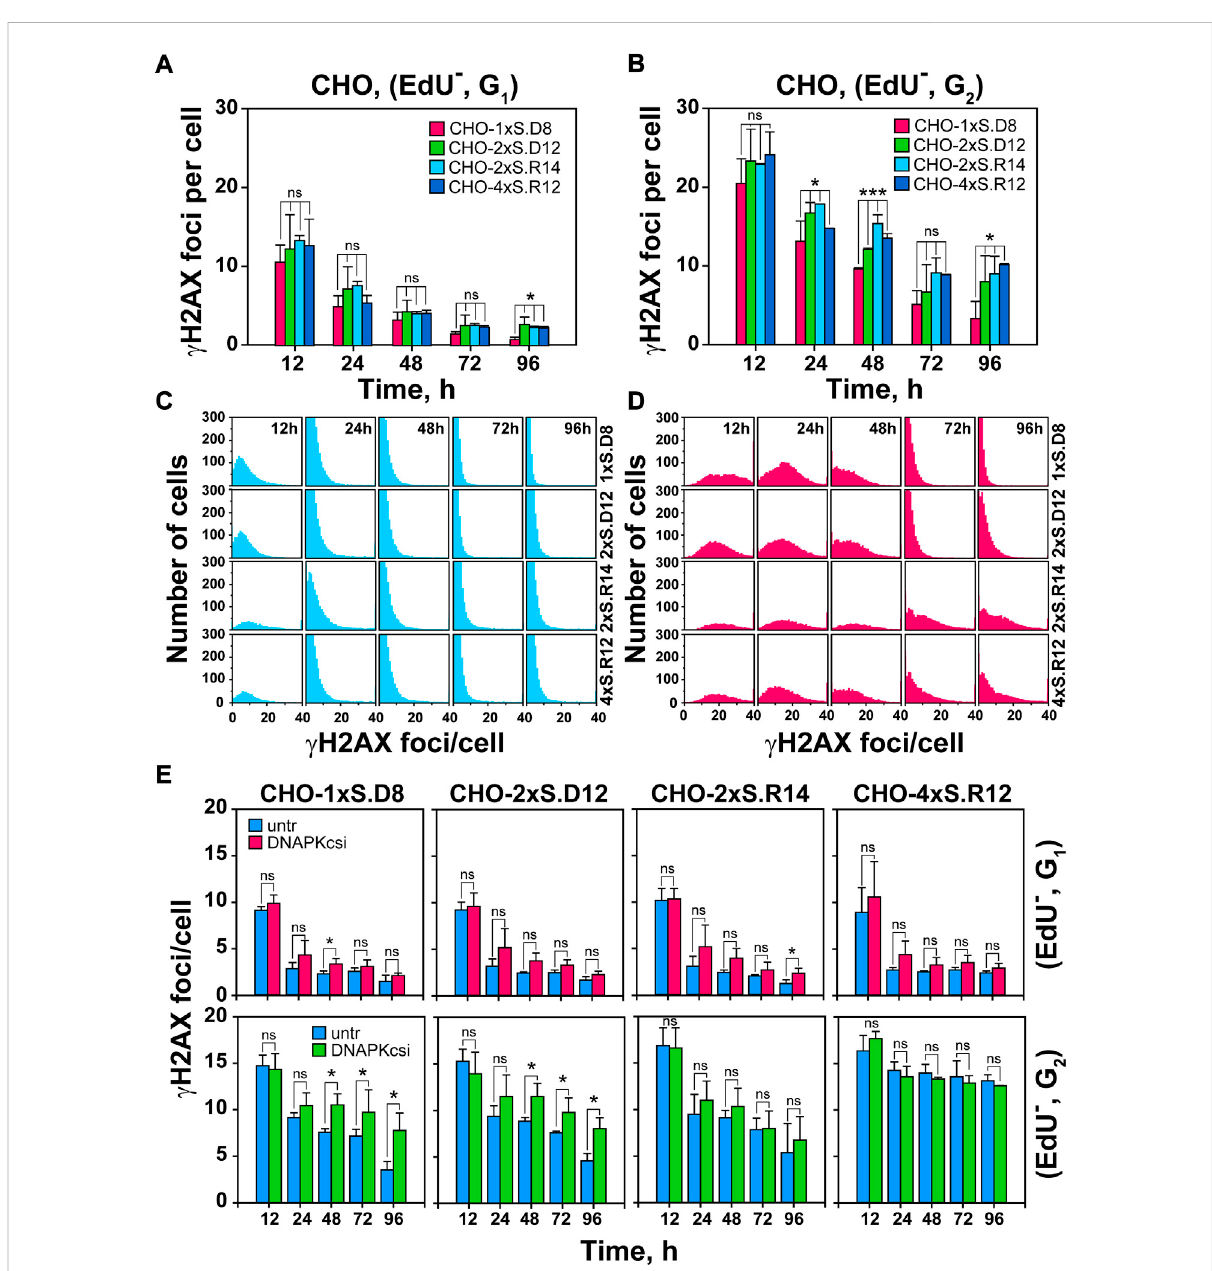
FIGURE 2 Increased DSB-complexity correlates with attenuated decay of γ H2AX foci in G 2 -phase cells; impact of DNA-PKcs-inhibition. (A) Quantitative analysis (QA)of γ H2AXfociformation anddecay inG 1 -phase cells,selectedaccordingto thegates de fi ned inSupplementaryFigure S1A.Fociscored inI-SceItransfectedcellsissubtractedfromthebackgroundfociscoredinmocktransfectedcells. (B) AsinFigure2A,butforEdU − ,G 2 -phasecells (C) Histogram plots of γ H2AX foci in EdU − , G 1 -phase cells. (D) As in Figure 2C, but for G 2 -phase cells. (E) Upper Panels: QA of formation and decay of γ H2AX foci in I-SceI transfected, G 1 -phase cells, after DNA-PKcs inhibition. DNA-PKcsi was administered immediately after transfection and was kept for 24 h. Lower Panels: As in the upper panels but for EdU − , G 2 -phase cells. Data represent means and standard deviations (±SD) from three independent experiments. (ns, no signi fi cance, p > 0.05); (* p ≤ 0.05); (** p ≤ 0.01); (*** p ≤ 0.001); (**** p ≤